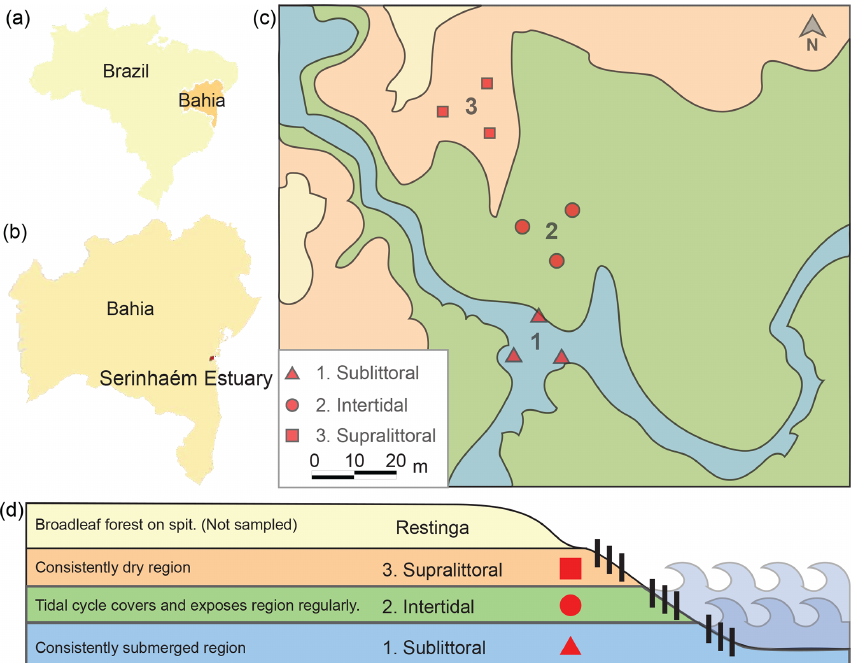
Figure 1. Map and schematic of sediment sampling sites. Here we show the locations of the sampling sites relative to Brazil (a) and Bahia (b) . A picture shows the relation of the three sampling sites within each zone (1 sublittoral, 2 intertidal, 3 supralittoral; c ). A schematic shows the topographic and tidal relation of each sampling site (d)